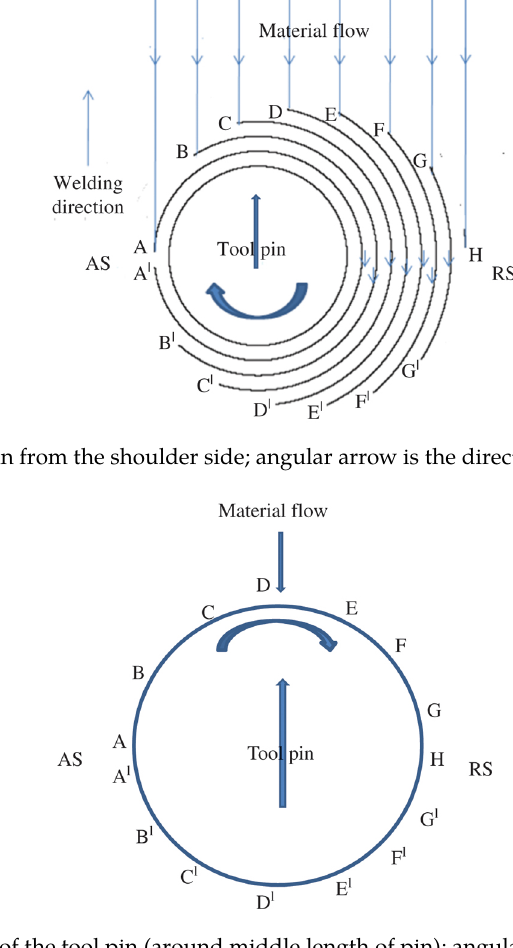
Figure 11: Exaggerated top view of the tool pin (around middle length of pin); angular arrow is direction of rotation; ar- row is the welding